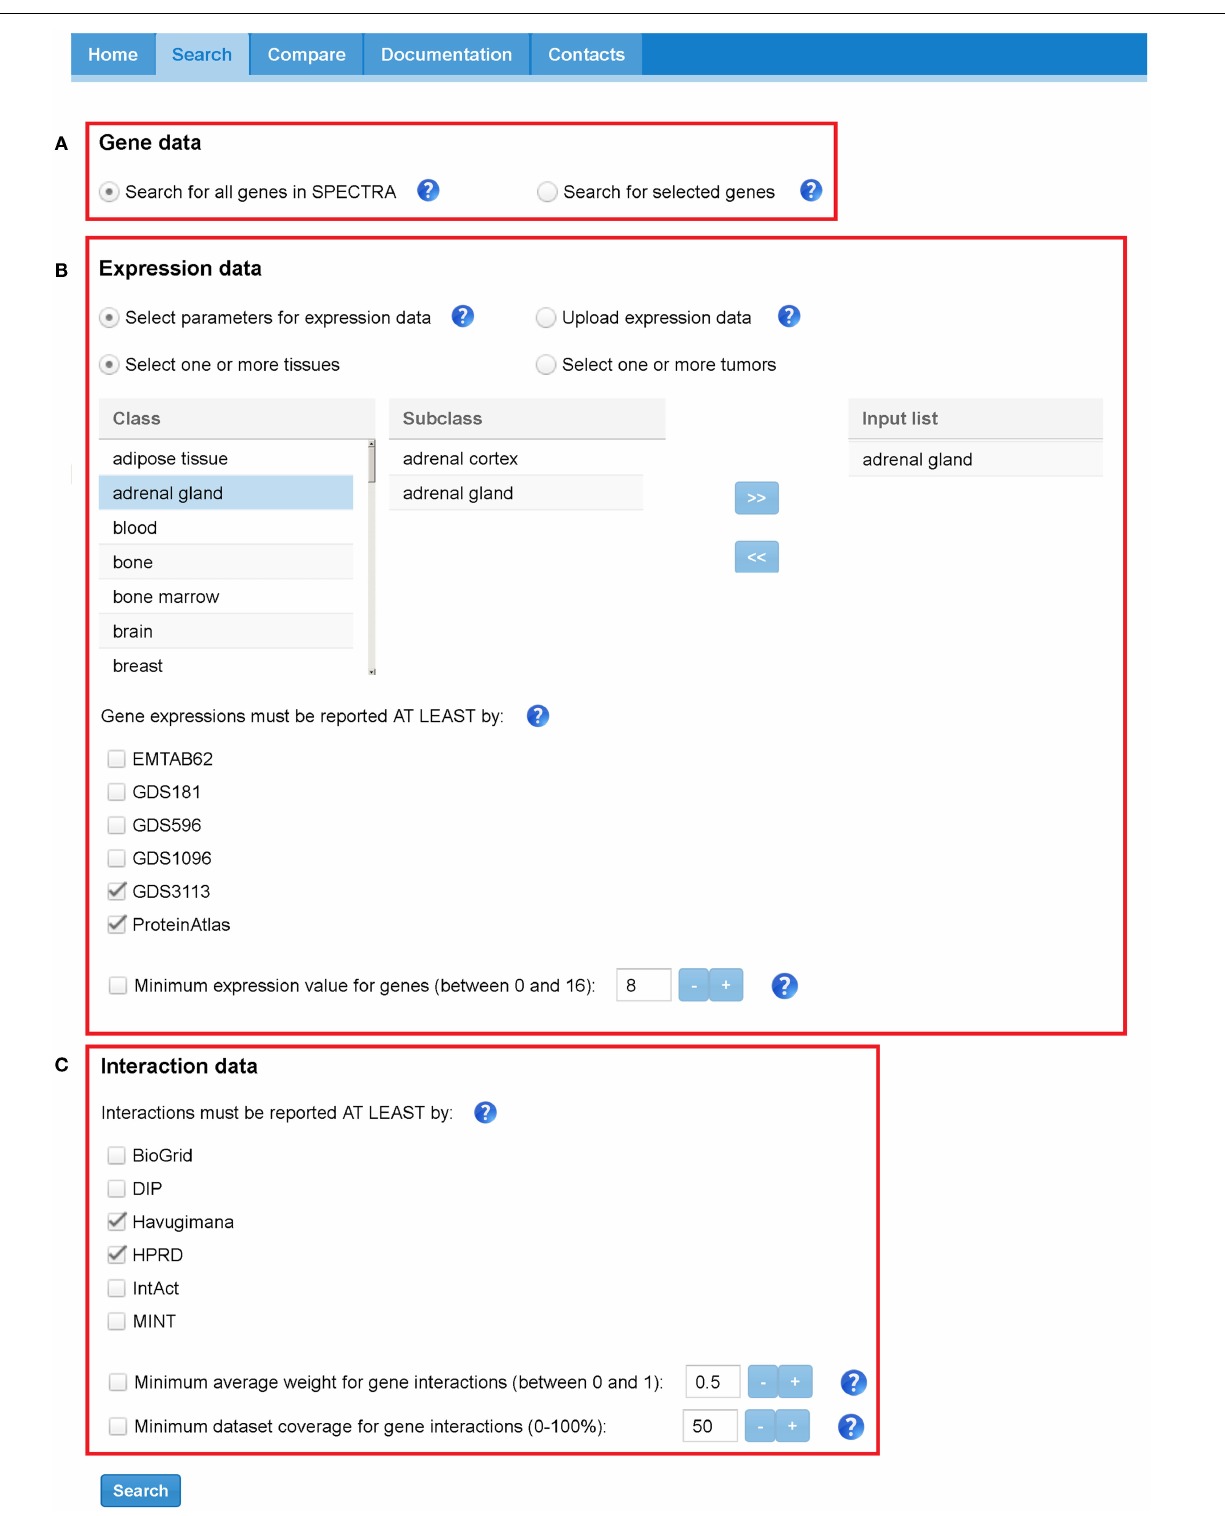
FIGURE 5 | SPECTRA search tabbed panel . Red boxes highlight the three sections: (A) “Gene data,” (B) “Expression data,” and (C) “Interaction data.” In this case, the parameters have been set to indicate that we want to retrieve all the interactions that are present at least in Havugimana and HPRD, involving